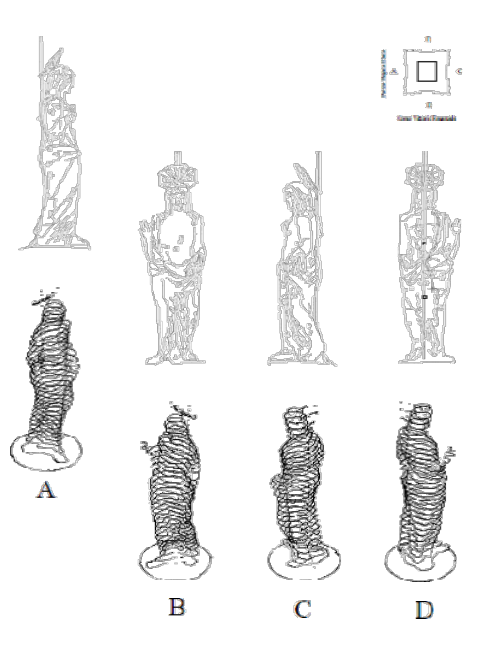
Figure 12: Position of the b arycentre arycentre curve (red) respect to the vertical axis vertical axis (yellow)